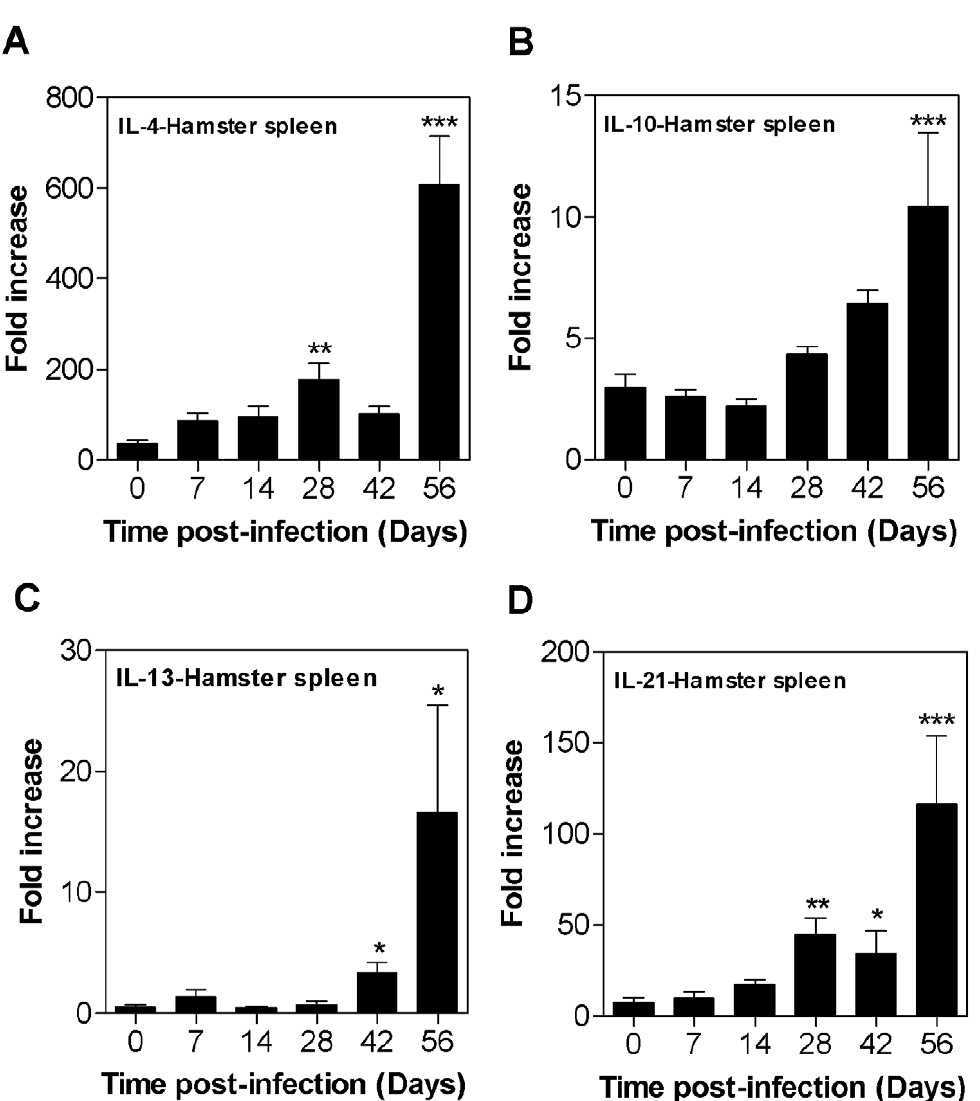
Figure 4. Kinetics of cytokine expression in spleen tissue during progressive visceral leishmaniasis. Expression of hamster IL-4 ( A ), IL-10 ( B ), IL-13 ( C ), and IL-21 ( D ) mRNAs in the spleens of control hamsters (0 days post-infection) and hamsters infected with L. donovani for 7, 14, 28, 42, and 56 days. The mean and standard deviation (error bars) of the fold-increase of cytokine mRNA relative to BHK cells, determined by real time RT- PCR in groups of 6 animals, is shown from a single experiment that is representative of 2 independent experiments. The statistical significance of differences in each of the panels is identified by asterisks (*, p , 0.05; **, p , 0.01; ***, p , 0.001).